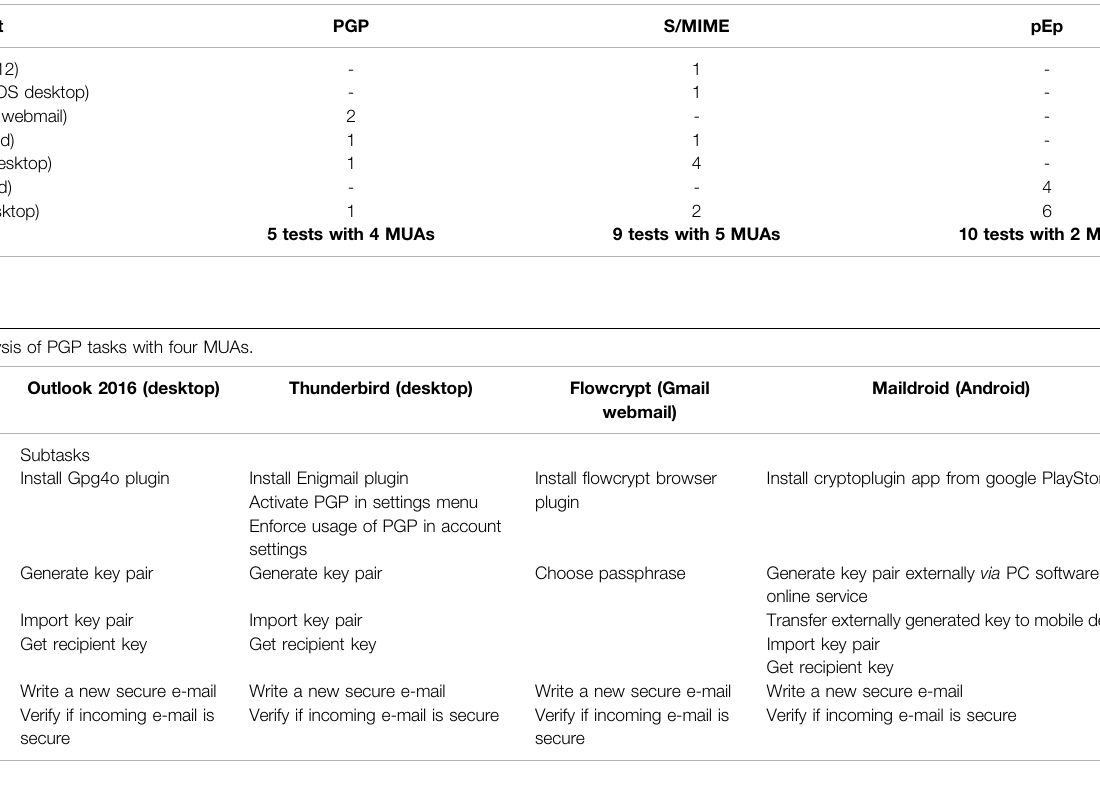
TABLE 4 | Confounding matrix of mail user agent (MUA) and encryption technology including the number of tests made.